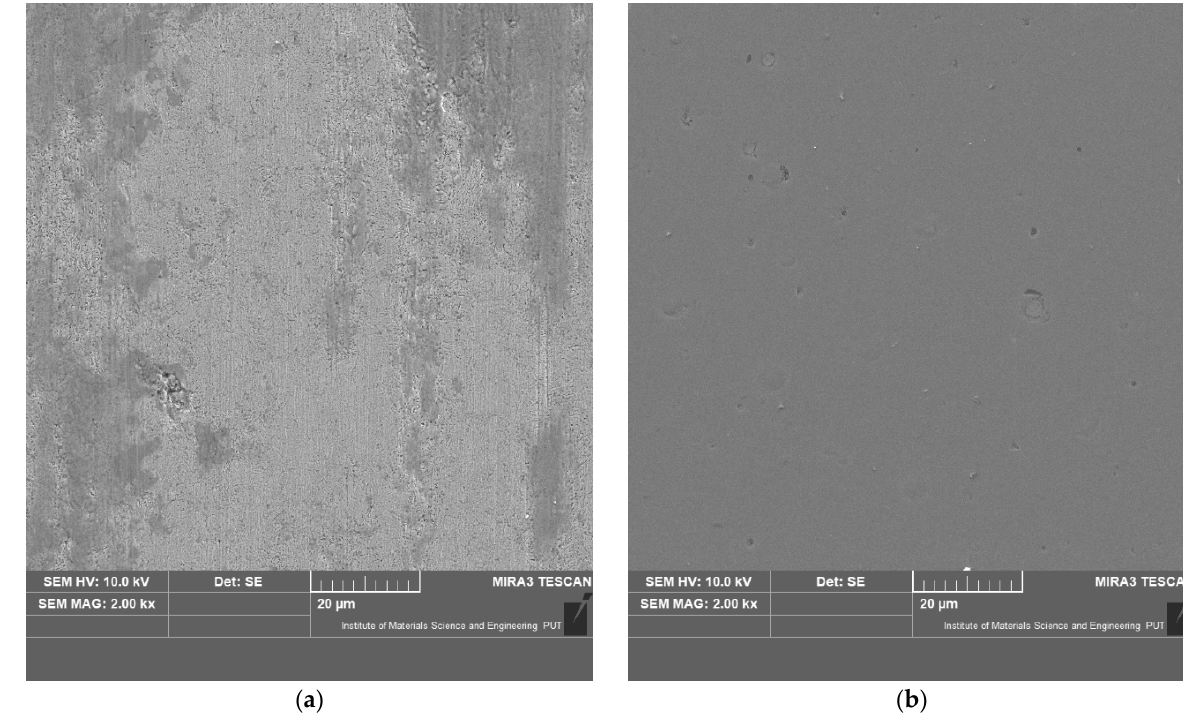
Figure 13. Pictures of the wear trace surface at an open circuit potential, E OCP , under the load of 13 N: ( a ) gas nitrided with subsequent oxidation and impregnation, ( b ) Cr/CrN PVD.